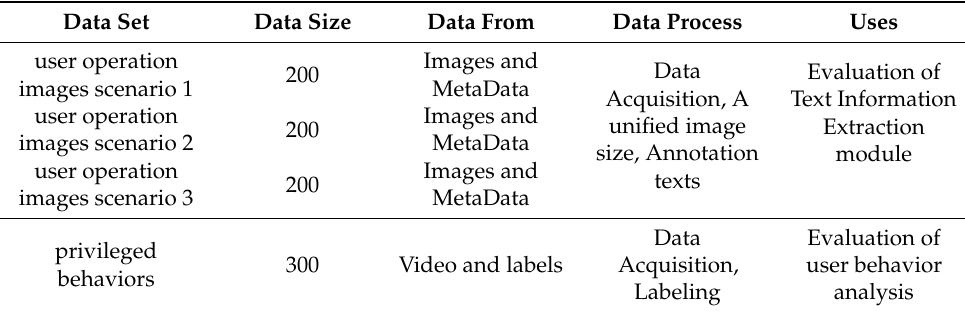
Table 3. Checklist of using data (Evaluation of User Behavior Auditing